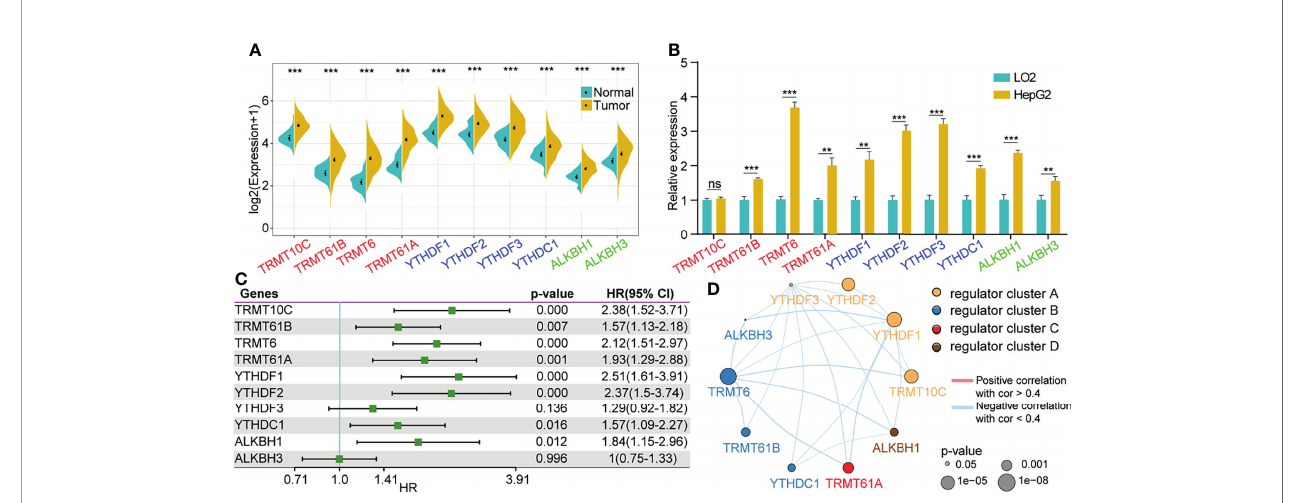
FIGURE 1 | Changes in m1A regulators were correlated with the prognosis of HCC patients. (A) Expression of 10 m1A-related genes in tumor tissues compared to normal liver tissues from the TCGA-LIHC cohort. (B) Expression of 10 m1A-related genes in the HepG2 cell line compared with the normal cell line L02. (C) Univariate cox analysis of the 10 regulators. (D) Construction of the m1A regulatory network. **P < 0.01, ***P < 0.001; ns,